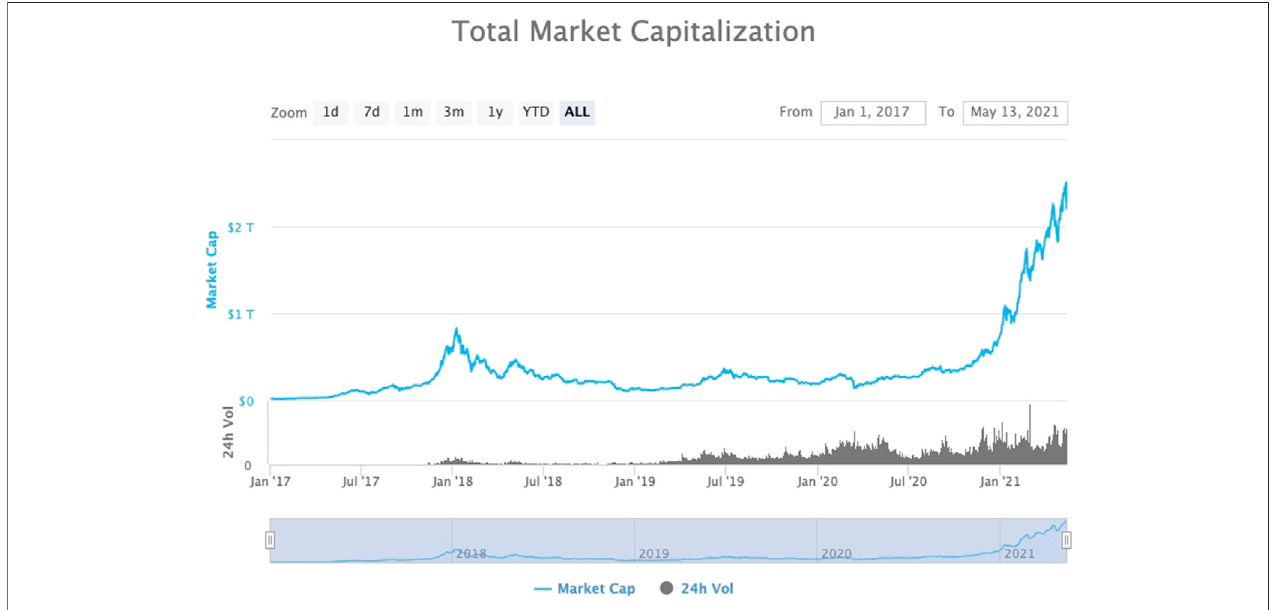
FIGURE 1 | Total market capitalization (log). Source: